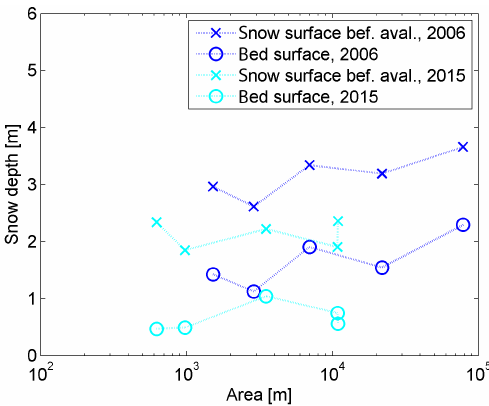
Figure 10. Release area size as a function of snow depth at the bed surfaces for the avalanches released in 2006 and in 2015.